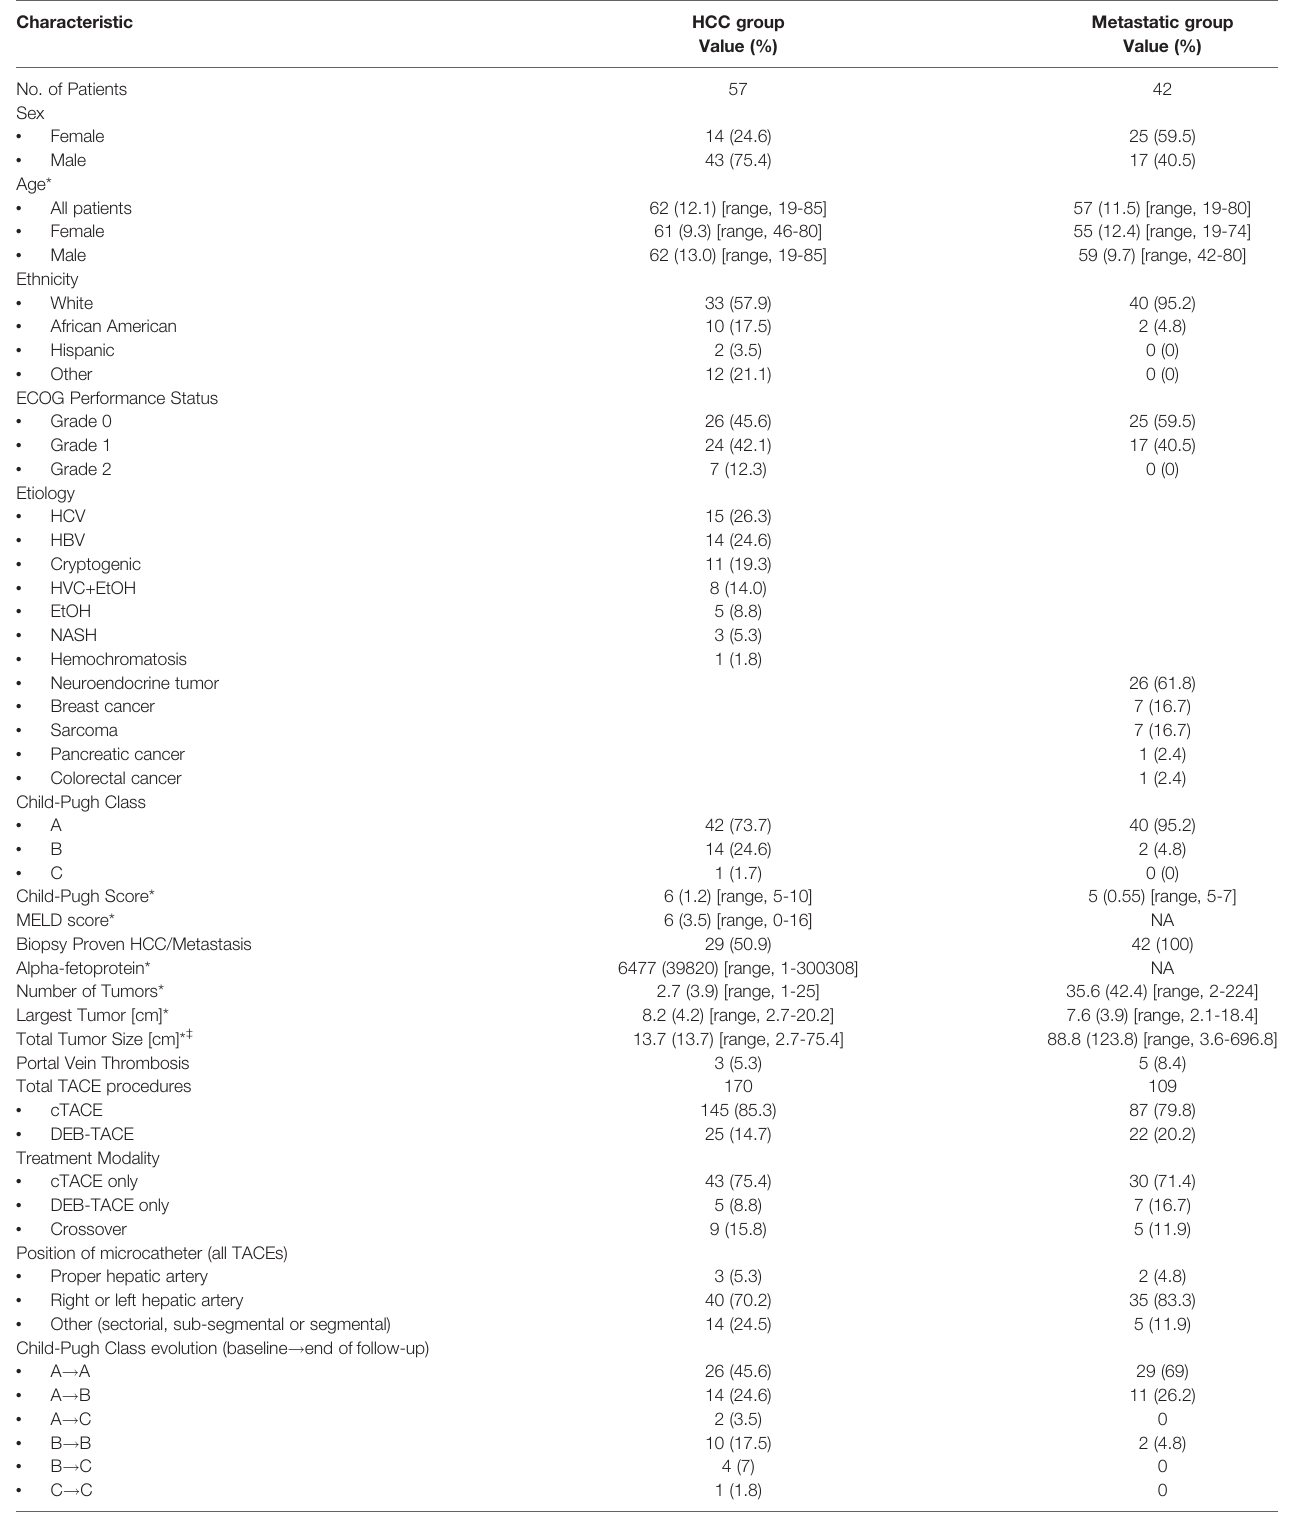
TABLE 1 | Baseline Patient and TACEs